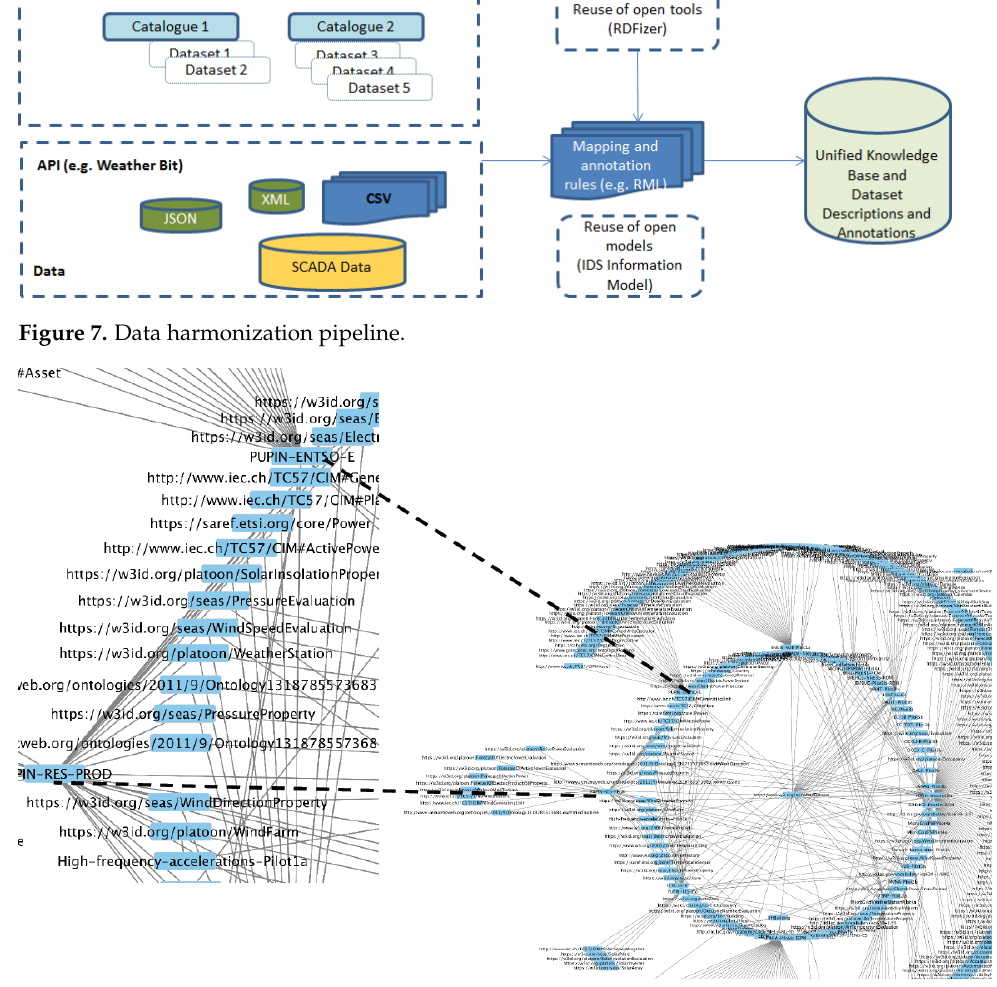
Figure 8. Annotation of data sources. Visualization powered by Cystoscape.